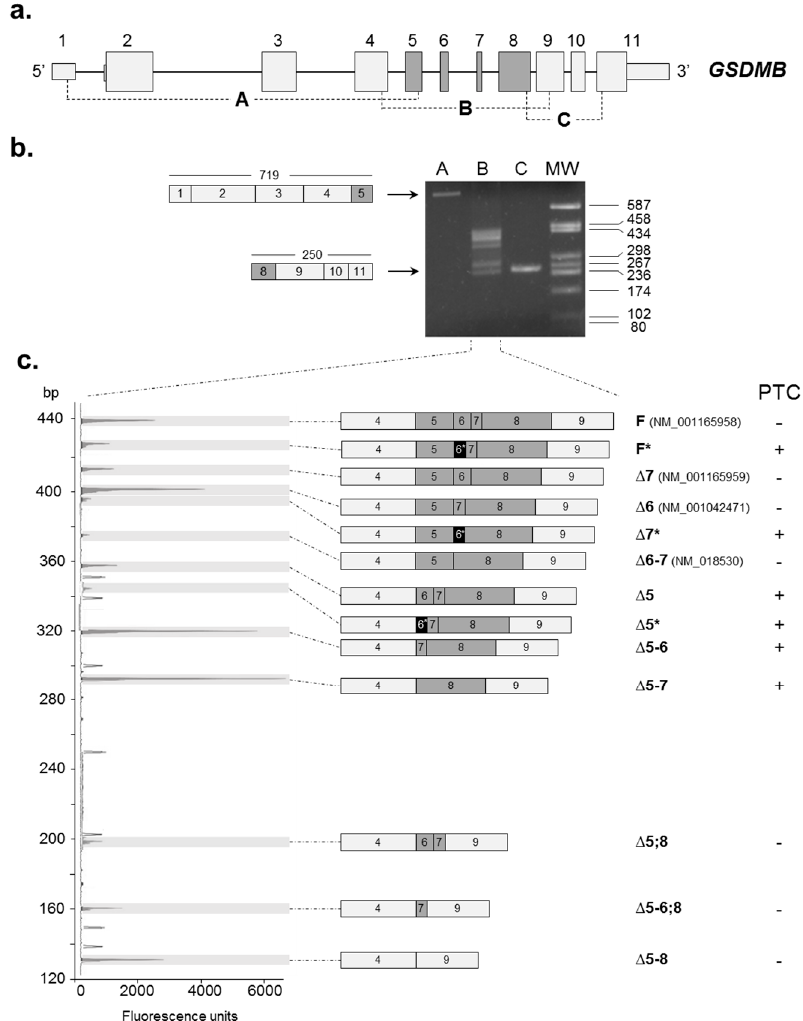
Figure 1. GSDMB alternative splicing (AS) pattern. ( a ) Schematic representation of the GSDMB gene. Exons are represented by boxes and are approximately drawn to scale; untranslated regions (UTRs) are depicted by smaller boxes; introns are represented by lines. Constitutive exons are colored in light grey and alternative exons in dark grey. The three reverse-transcription (RT)-PCR assays (A, B, and C) performed to cover the GSDMB coding region are indicated; ( b ) An illustrative agarose gel (2%) shows the amplification products of the three RT-PCR assays. For “A” and “C” assays, the unique amplification product and their length, expressed as base pairs (bp), are schematized on the left. For the “B” assay, multiple specific amplification products were obtained, corresponding to several AS events involving exons 4 to 9, which were further analyzed by both fluorescent RT-PCR and direct sequencing (see further). MW: molecular-weight marker (pUC9- Hae III); ( c ) The left panel represents a demonstrative GeneMapper window showing the fluorescent RT-PCR products of the “B” assay (on RNA extracted from a healthy individual, heterozygous for the rs11078928 polymorphism), using the forward primer labelled with the HEX fluorophore. The filled peaks, shaded in grey, correspond to the RT-PCR products; empty peaks represent the size standard (ROX-500 HD). The vertical axis indicates the length of amplified products in bp, whereas the horizontal axis shows fluorescence units. The schematic representation and the name of the corresponding isoform product are indicated on the right side. The alternative exon 6* is depicted in black. F”: full length, “*” indicates the presence of exon 6* in the isoform, “ ∆ ” is followed by the skipped exon, separated by “-” or “,” if the exons are contiguous or not, respectively. The accession number of University of California, Santa Cruz (UCSC) Genome Browser-annotated isoforms is also indicated. The presence/absence in the transcript of a premature termination codon (PTC) is indicated by a “+”/“ − ”, respectively.